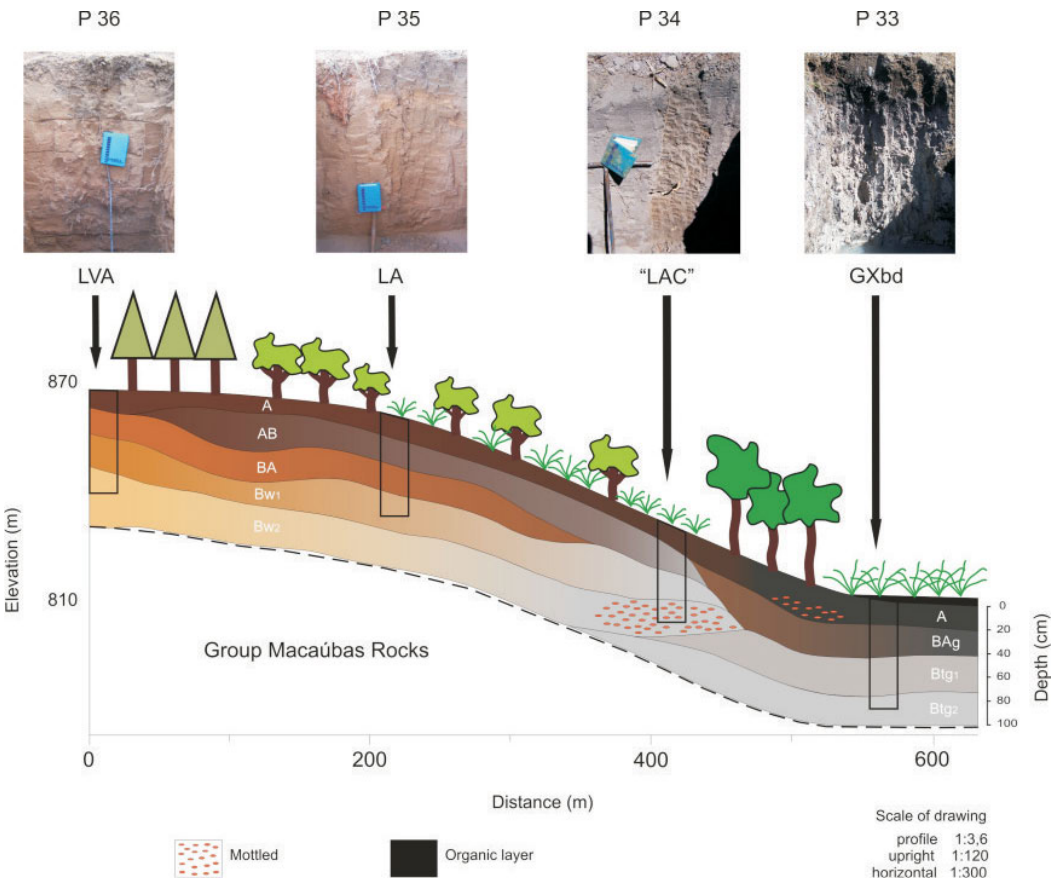
Figure 3. Lateral configuration of soil horizons on the slope of the Lagoa do Leandro